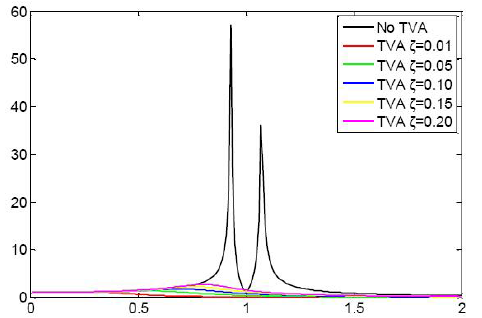
Figure 4. Basic structure of the MRE vibration